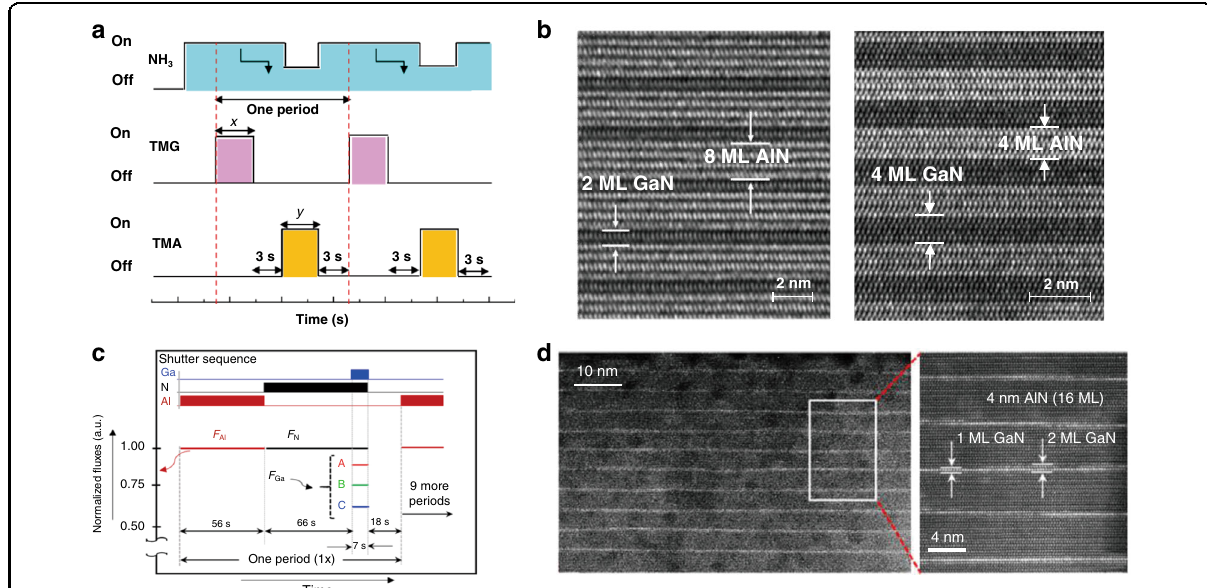
Fig. 4 Schematic sequence and the cross-sectional morphologies for the grown short-period (AlN) m /(GaN) n SLs. a MOCVD schematic sequence and b high-resolution cross-sectional TEM images for the hierarchical growth units of (AlN) m /(GaN) n short-period SLs with different well and barrier thicknesses. c MBE growth diagram showing shutter sequence for a single period of the growth and d the Z-contrast STEM images for the 10 periods of GaN/AlN heterostructures. Figures reproduced from a and b ref. 71 , © 2019 American Chemical Society; c and d ref. 73 , © 2017 AIP